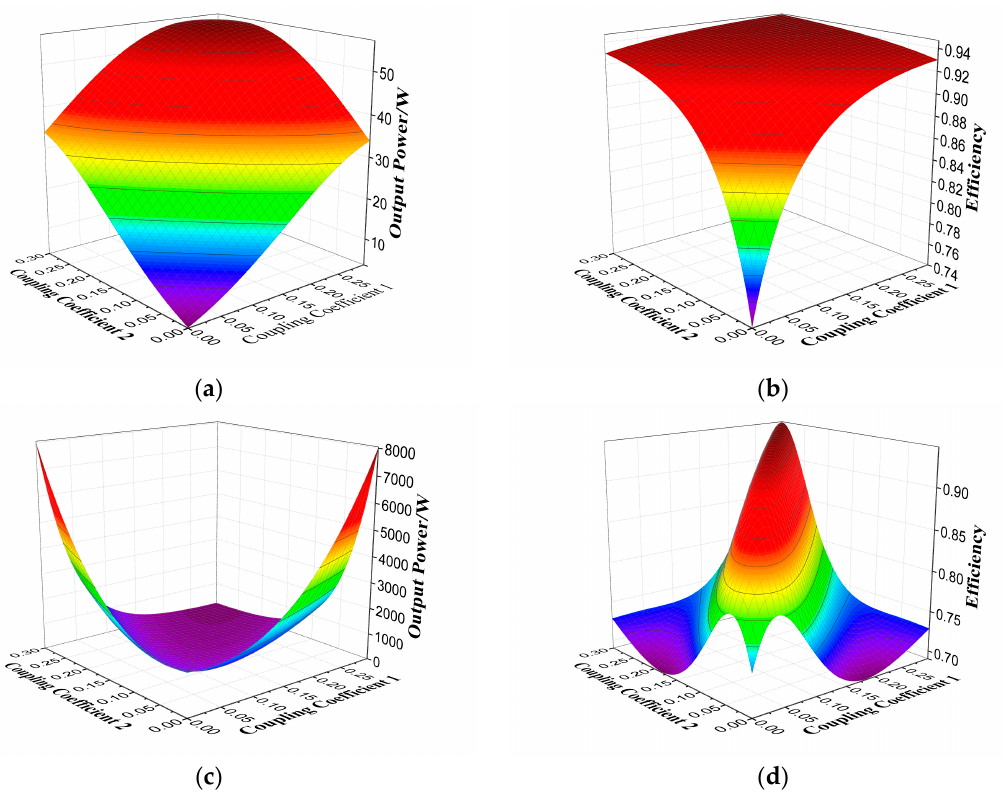
Figure 8. Output characteristics under mutual inductance variation of DEU-WPT: ( a ) Output power under mutual inductance variation of PS-type DEU-WPT; ( b ) Efficiency under mutual inductance variation of PS-type DEU-WPT; ( c ) Output power under mutual inductance variation of SS-type DEU-WPT; ( d ) Efficiency under mutual inductance variation of SS-type DEU-WPT.